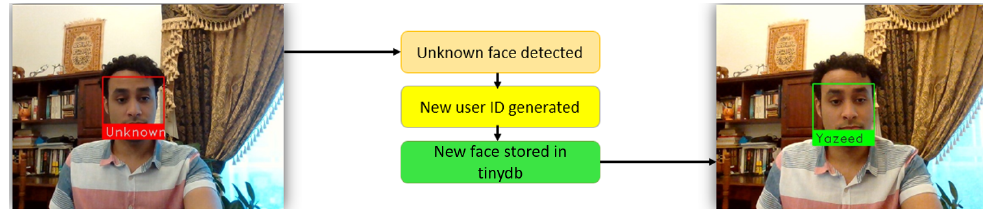
Figure 7. Face recognition algorithm